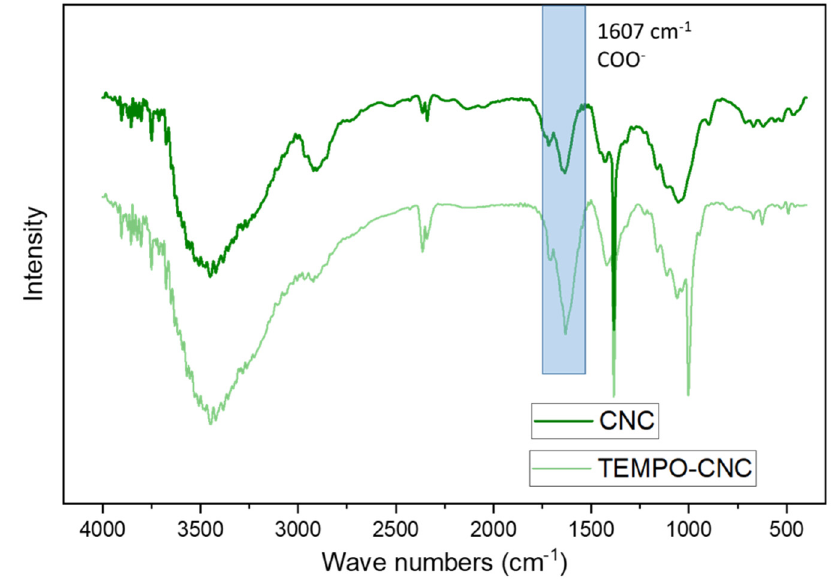
Figure 2. FTIR spectra of cellulose nanocrystals (CNCs) (dark green curve), TEMPO CNCs (light green curve).